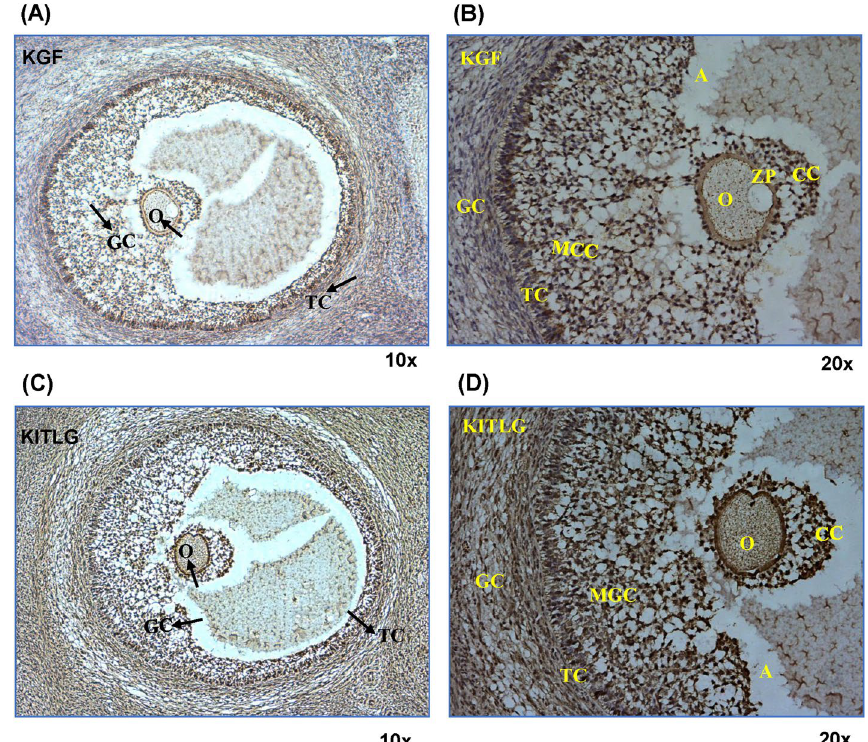
Fig. 5 Immunohistochemical localization of KGF and KITLG in buffalo ovarian sections. Brown color represents staining of targeted proteins, KGF and KITLG, while blue color is background counter staining. Arrow heads indicate the oocyte, granulosa and theca cells. A , B Expression of KGF at granulosa and theca cells. C , D show the expression of KITLG at all three sites at granulosa, theca and oocyte. Magnification is Oocyte, ZP: Zona pellucida, GC: Granulosa cells, A: Antrum, TC: Theca cells, MGC: Mural GC, CC: cumulus